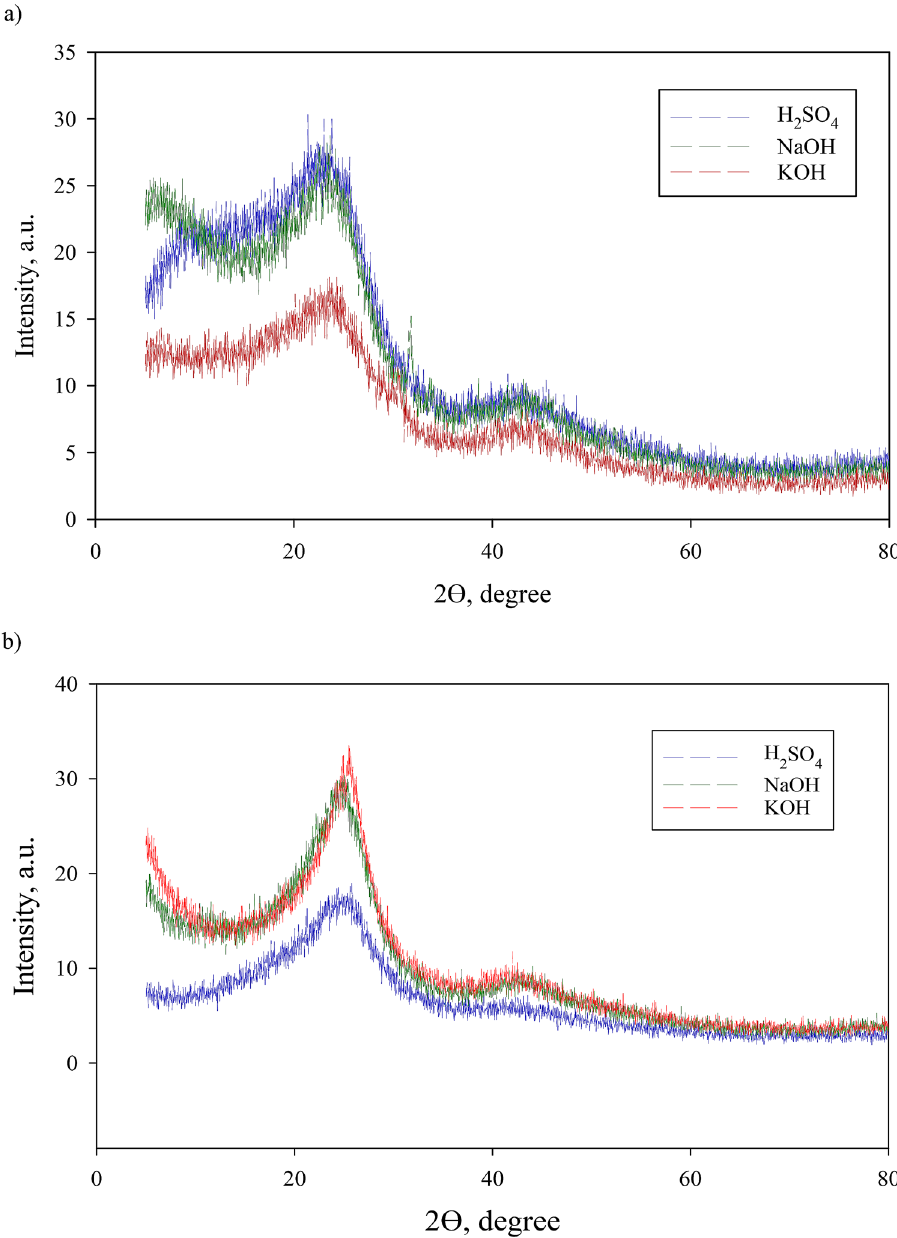
Figure 1. ( a ) XRD of the PAC from RSS based on activation solutions and ( b ) XRD of the PAC from RS based on activation